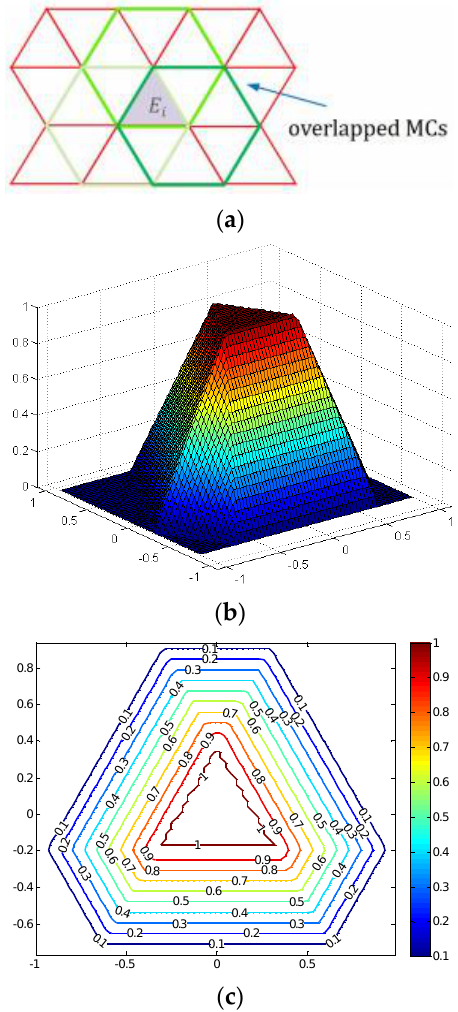
Figure 2. PU of weight functions over the triangular mesh: ( a ) Manifold element and overlapped MCs; ( b ) PU function; ( c ) contour of the PU function.